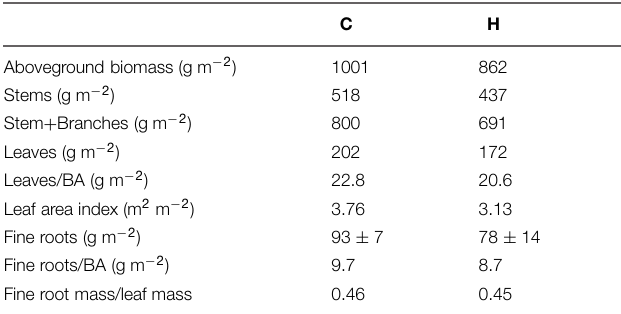
TABLE 4 | Biomass accumulation of birches in control (C) and humidified plots